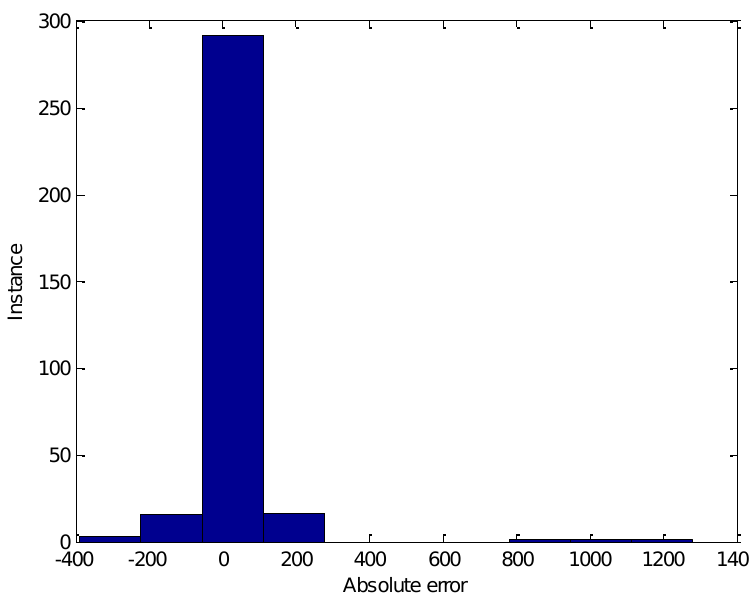
Figure 5. Histogram of CNN for all data .